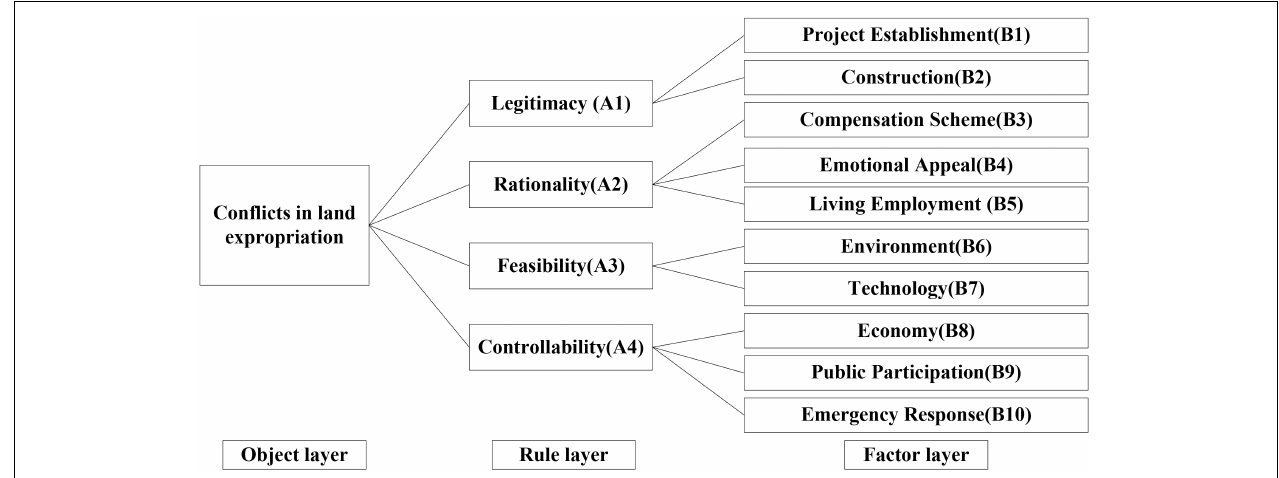
FIGURE 4 | Hierarchical structure for risk assessment of conflicts in land